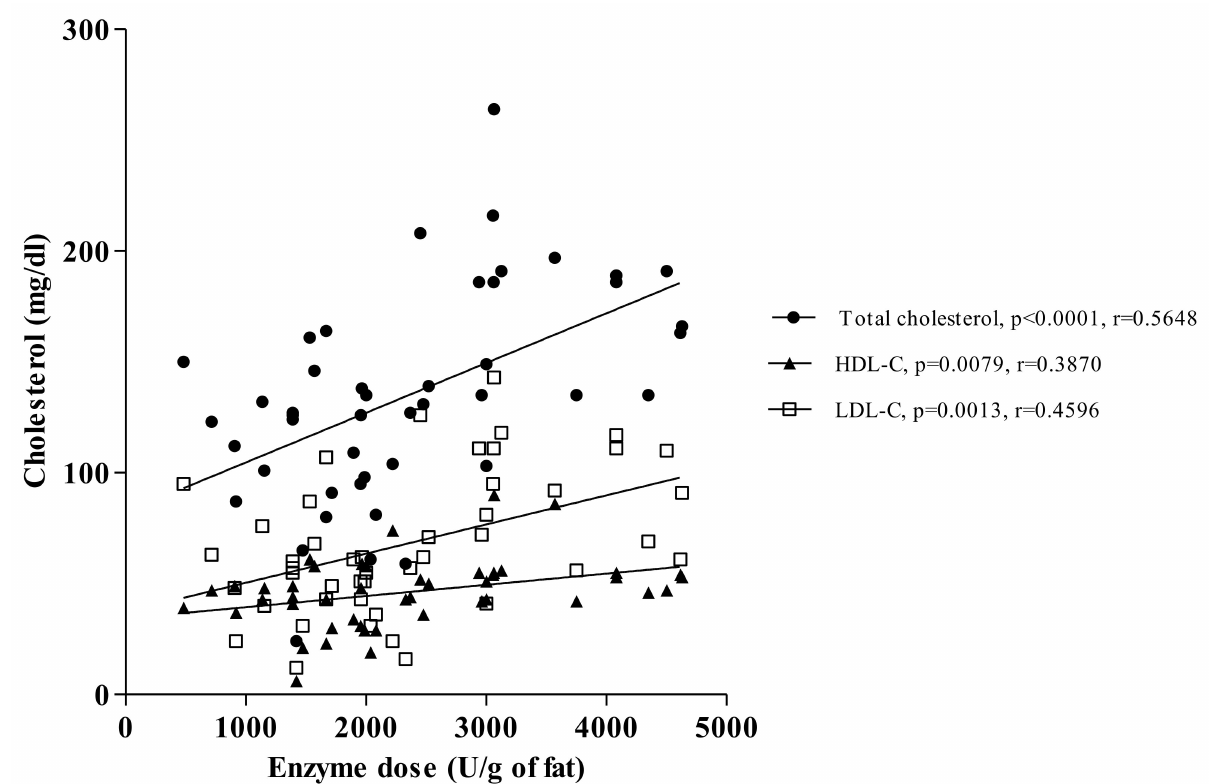
Figure 3. The relationships between enzyme intake (lipase units/g of fat) and serum cholesterol concentration (mg/dL) in pancreatic-insufficient